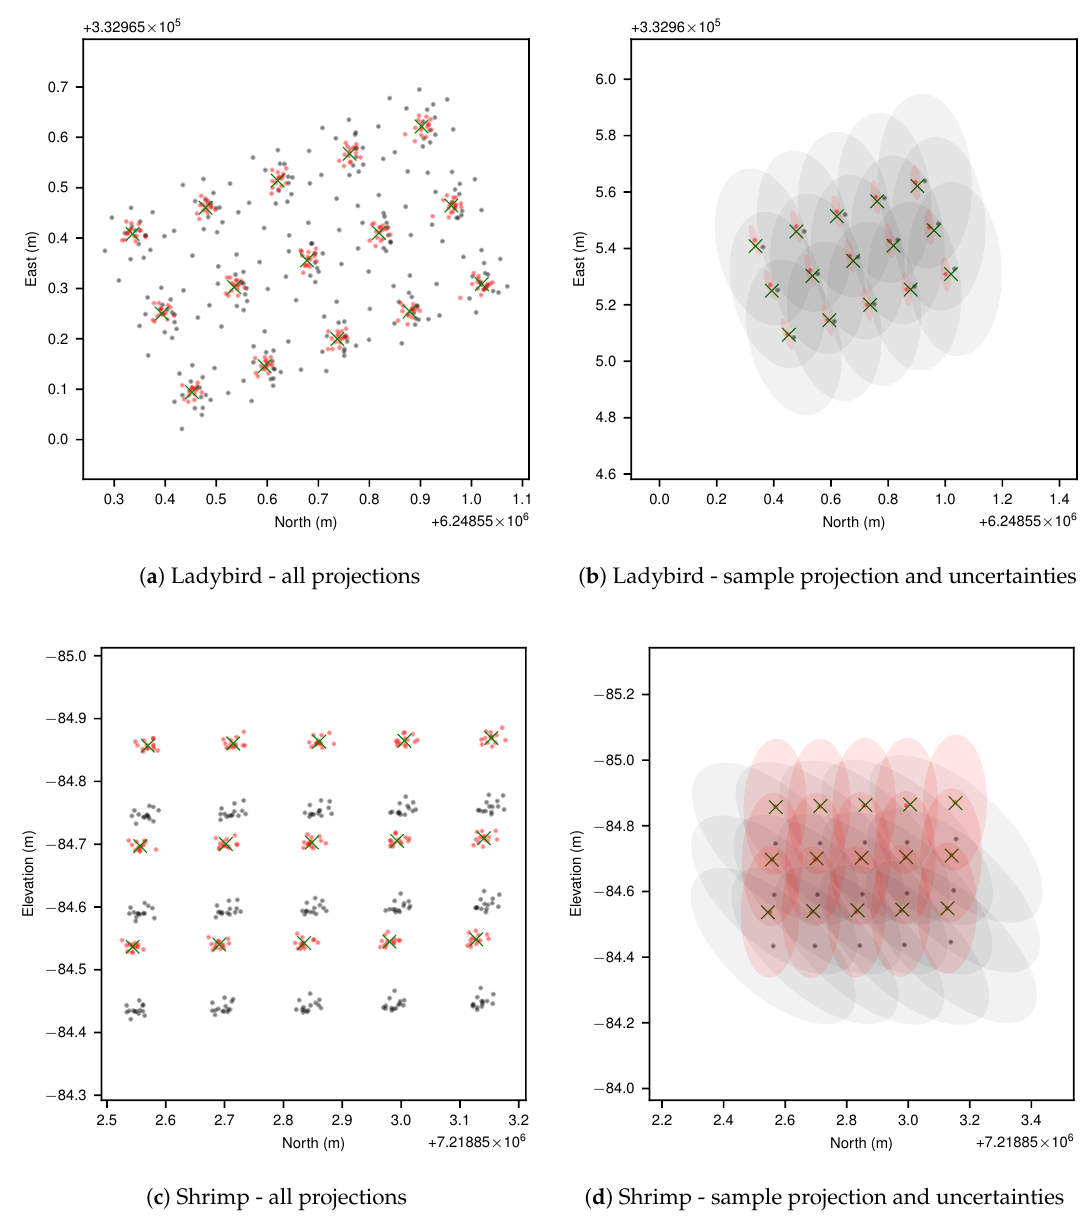
Figure 13. Point to plane projection comparisons for both platforms. In ( a , c ) all scans of all pattern points are plotted to best fit planes before (grey) and after (red) calibration, while in ( b , d ) a single projected observation of each pattern point is shown with 1- σ uncertainty ellipses. In all figures, post-calibration pattern point estimates are marked with green crosses for reference. Because the calibration pattern was positioned flat on the ground for Ladybird, a top down (North-East) view was selected for ( a , b ). Conversely, for Shrimp the calibration pattern was positioned almost vertically on a ladder, facing west, and therefore a side view (North-Elevation) was selected for ( c , d